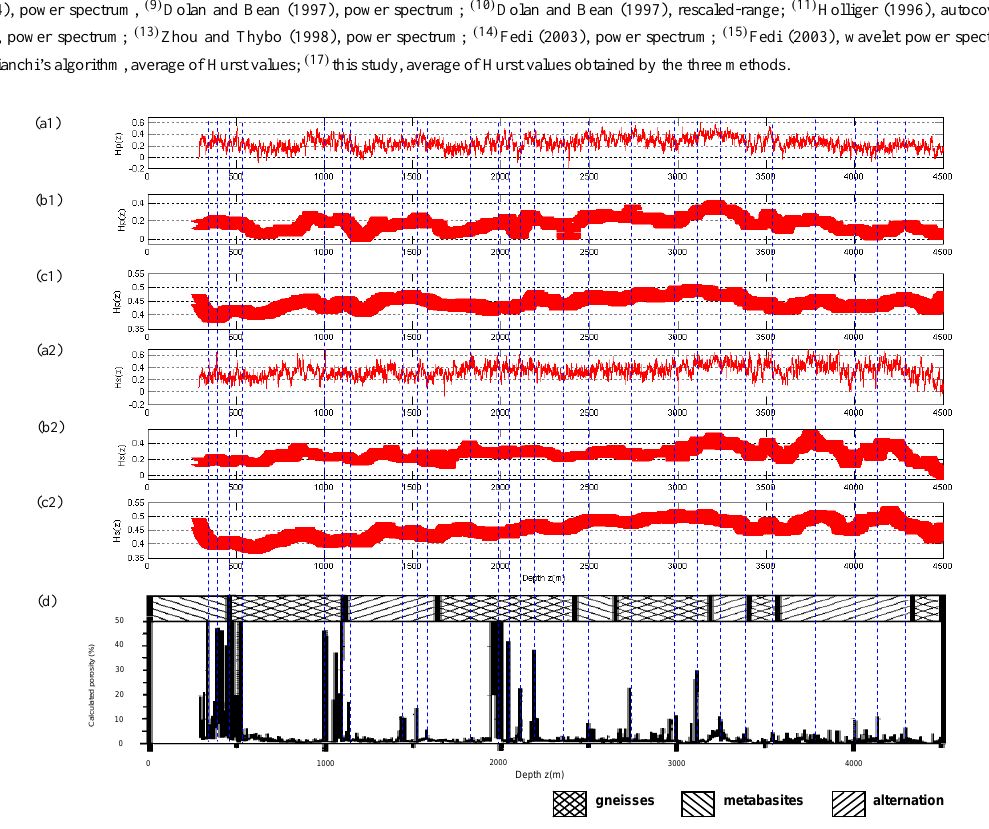
Fig. 6. A comparison between the Hurst functions obtained from sonic logs recorded at the main borehole (HB) and the estimated porosity log. The same abbreviations as in Fig.